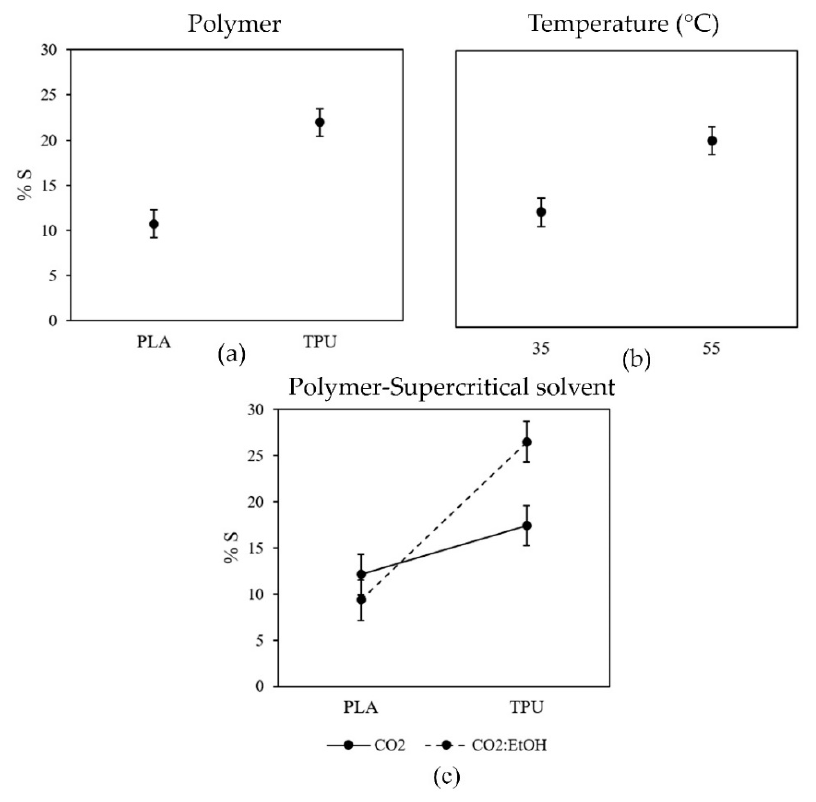
Figure 3. Plots of the multifactorial ANOVA analysis. Means plots for the statistically signifi- cant single factors: ( a ) polymer and ( b ) temperature, and interaction plots between two factors: ( c ) polymer-supercritical solvent, on the swelling of the polymer filaments (%S). All impregnation runs were performed for 30